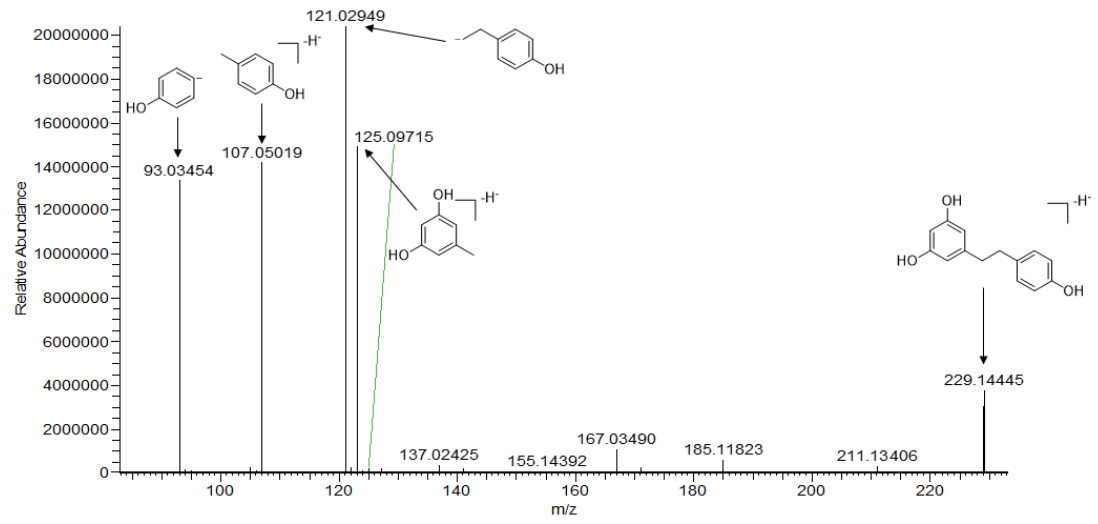
Figure 4. The possible fragmentation mechanism of dihydro-resveratrol.